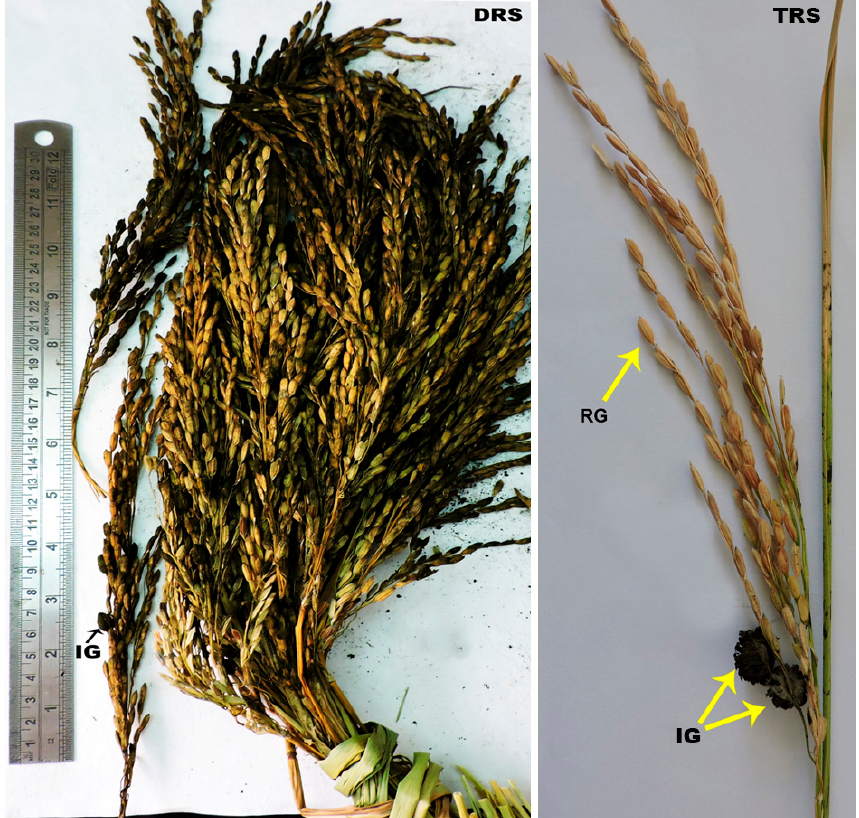
Figure 1. Panicle from infected rice varieties Dharam (DRS) and Thangjim (TRS) susceptible to U. virens portraying false smut of rice. IG is infected grain and RG is rice grain uninfected. The scale bar is 30 cm.